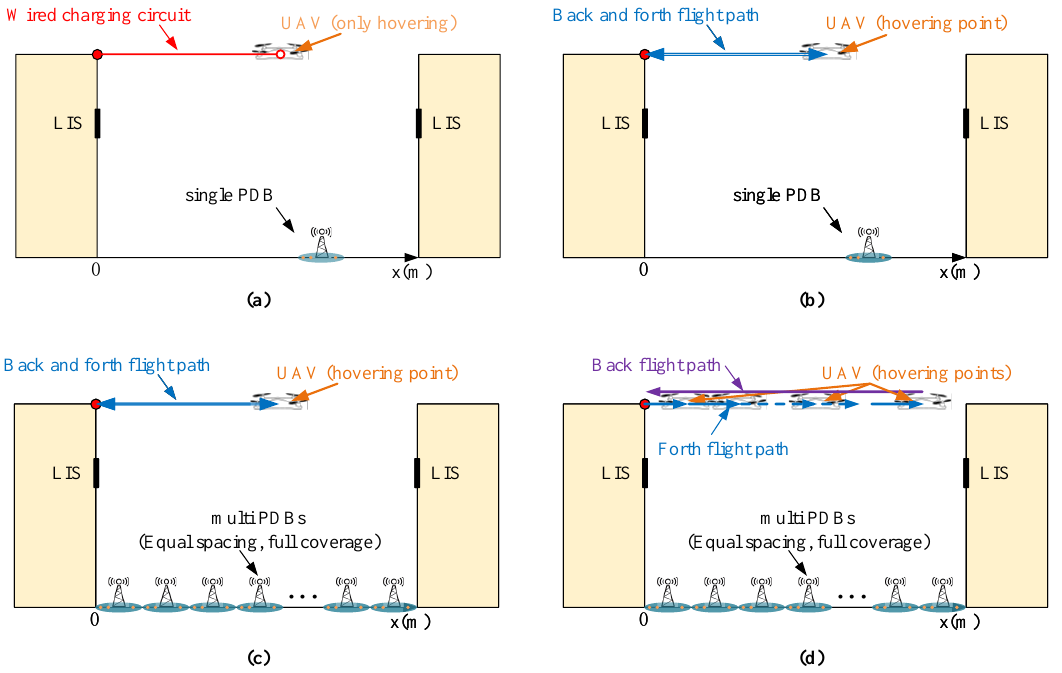
Figure 6. Actual situations of the scene presented in Figure 1: ( a ) Scene I , ( b ) Scene II , ( c ) Scene III , and ( d ) Scene IV